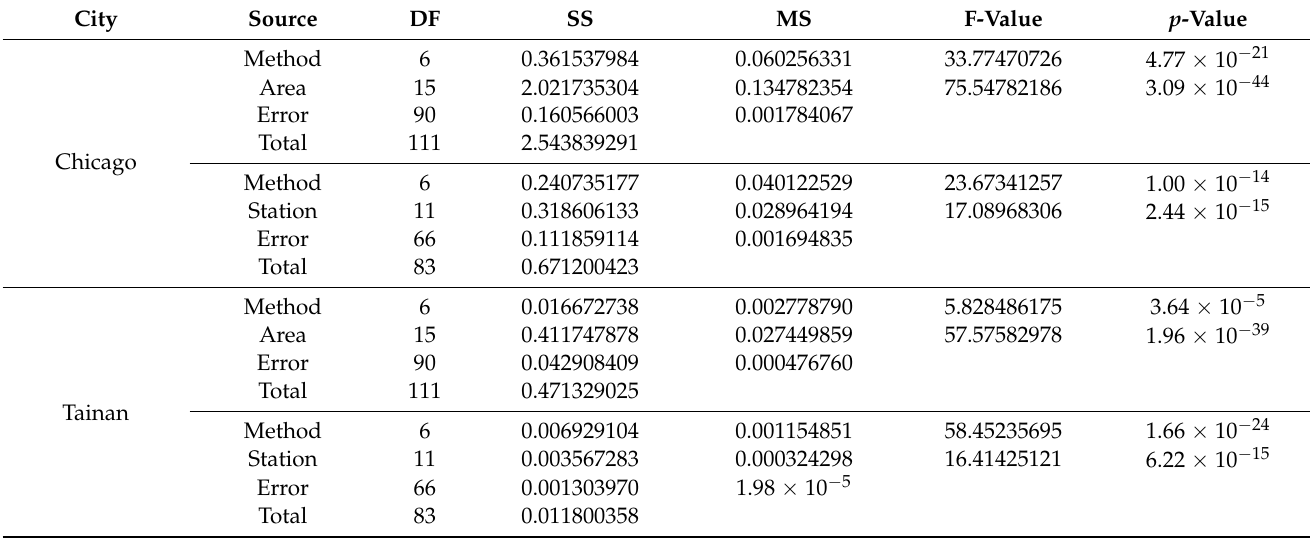
Table 7. Two-way ANOVA test for different methods and constraints towards unit PF performance.